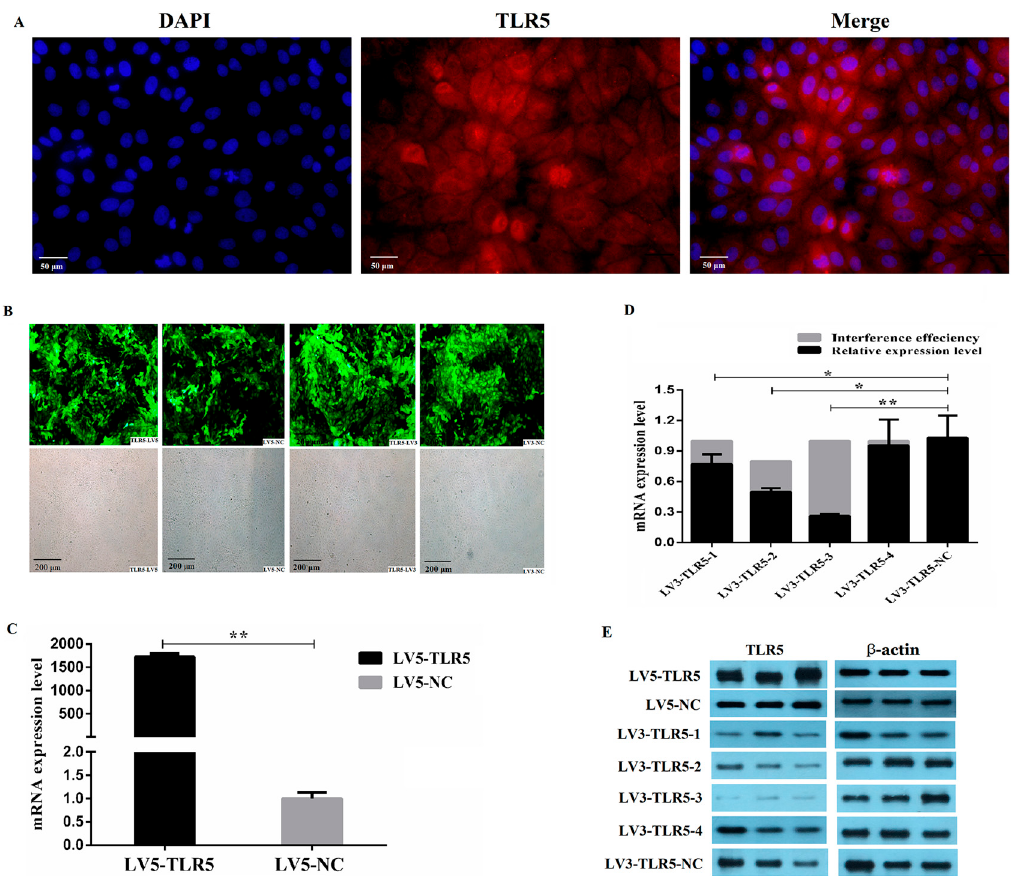
Figure 2. Cellular localization of TLR5 protein in intestinal epithelial cell lines (IPEC-J2) cells and establishment of IPEC-J2 cell lines with TLR5-RNA interference (RNAi) and overexpression. ( A ) Cellular localization of TLR5 protein in IPEC-J2 cells by indirect immunofluorescence. Blue fluorescence represents nucleus stained by DAPI; red fluorescence represents cytoplasm and cell membrane combined with TLR5 antibody. Cells were observed by fluorescence microscopy (200 × ). ( B ) Expression of green fluorescent protein (GFP) in IPEC-J2 after cells were infected by lentivirus solution for 24 h (100 × ). ( C ) TLR5 mRNA levels in LV5-TLR5 and LV5-NC measured by qPCR. **, p < 0.01. ( D ) TLR5 mRNA levels in LV3-TLR5-1, LV3-TLR5-2, LV3-TLR5-3, LV3-TLR5-4, and LV3-TLR5-NC measured by qPCR. *, p < 0.05; **, p < 0.01. ( E ) Protein expression levels of TLR5 in cells subjected to seven lentivirus types determined by Western blot.